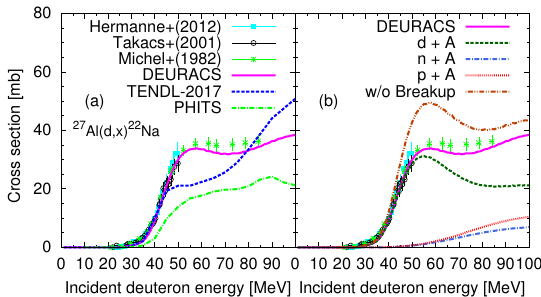
Figure 5. Same as figure 4 but for the rhodium isotopes produc- tion from the 107 Pd( d , x ) reaction at 200 MeV. Experimental data are taken from Ref.